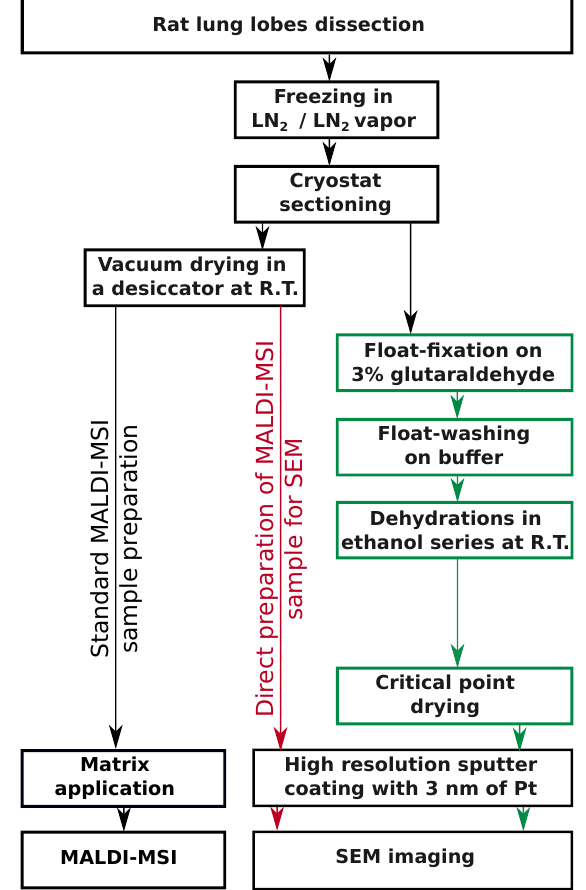
Figure 1. An overview of lung sample processing for SEM and MSI. The individual steps of the float-fixation/washing procedure are shown in green. MALDI-MSI samples directly prepared for SEM are enhanced in red. Additionally, parallel processing of frozen vacuum-dried lung tissue sections for MALDI-MSI analysis is shown in black in the left part of the panel. Color coding was selected according to AAAS color palette [34]. LN 2 , liquid nitrogen; R.T., room